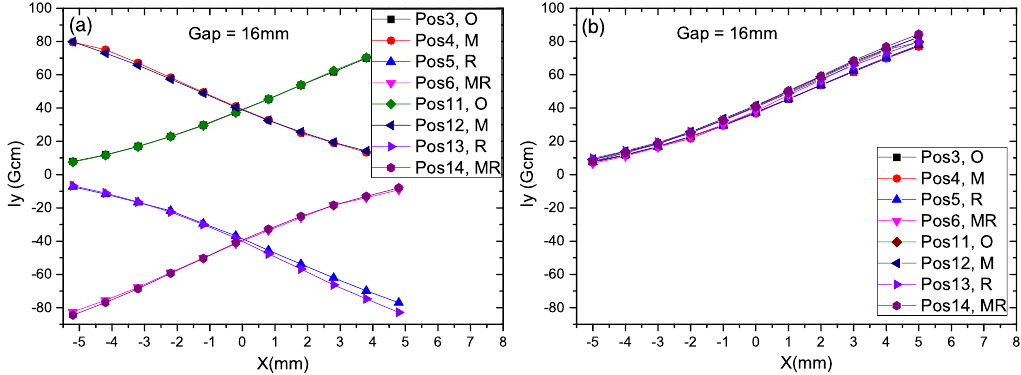
FIG. 6. Measurements of the total first vertical field integral as a function of x with a shim of 36 × 8 × 0 . 4 mm placed on O , M , R , and MR positions as indicated. (a) Measured data. (b) Data transformed back by using the symmetry properties of Table III.